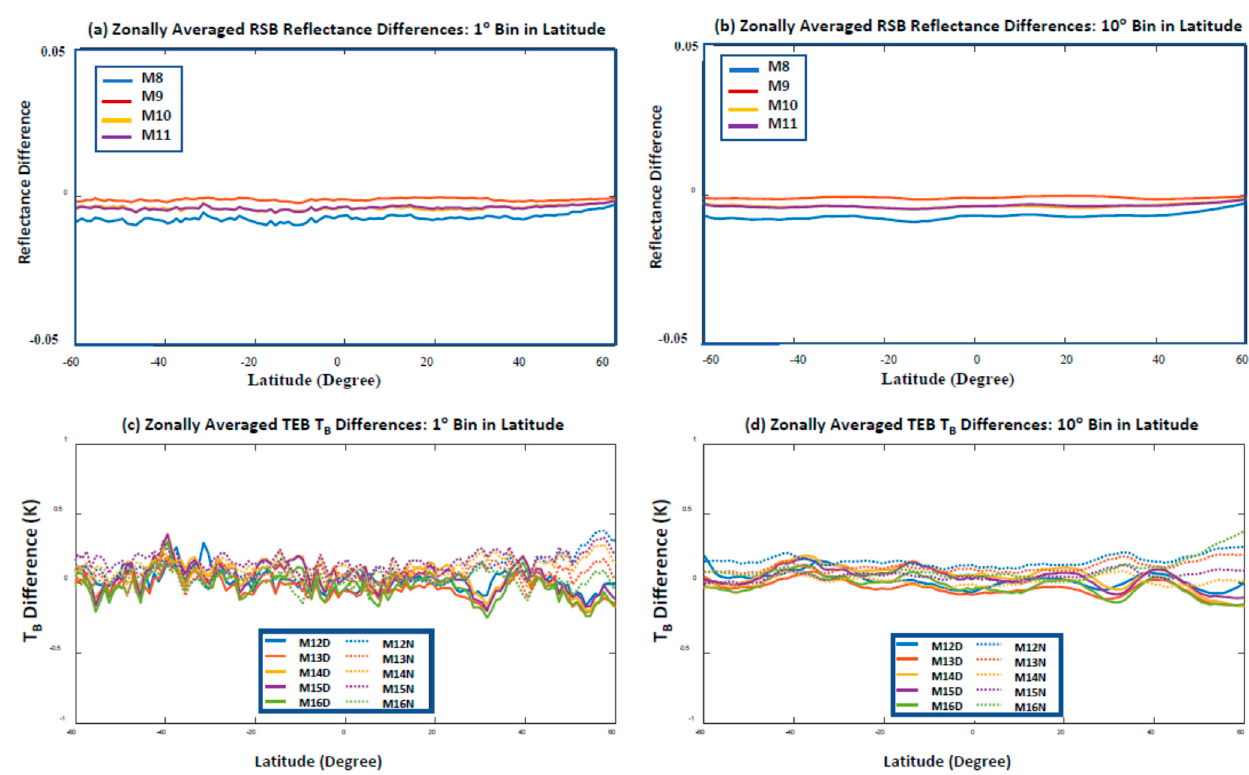
Figure 17. Zonal means of the 32D-AD at the 4 RSBs from M8 to M11 and 5 TEBs from M12 to M16, which are computed at each 1 ° latitude bin and the 10 ° running latitude bin, respectively andthe number on the X-axis is the center of the bin. In ( a , b ), the data are day time data, while in ( c , d ), ‘D’ and ‘N’ denote the data during the day time and nighttime respec- tively. ( a ) One-degree-bin zonal means for 4 RSBs, ( b ) ten-degree-bin zonal mean for 4 RSBs, ( c ) one-degree-bin zonal means for 5 TEBs, and ( d ) ten-degree-bin zonal mean for 5 TEBs.